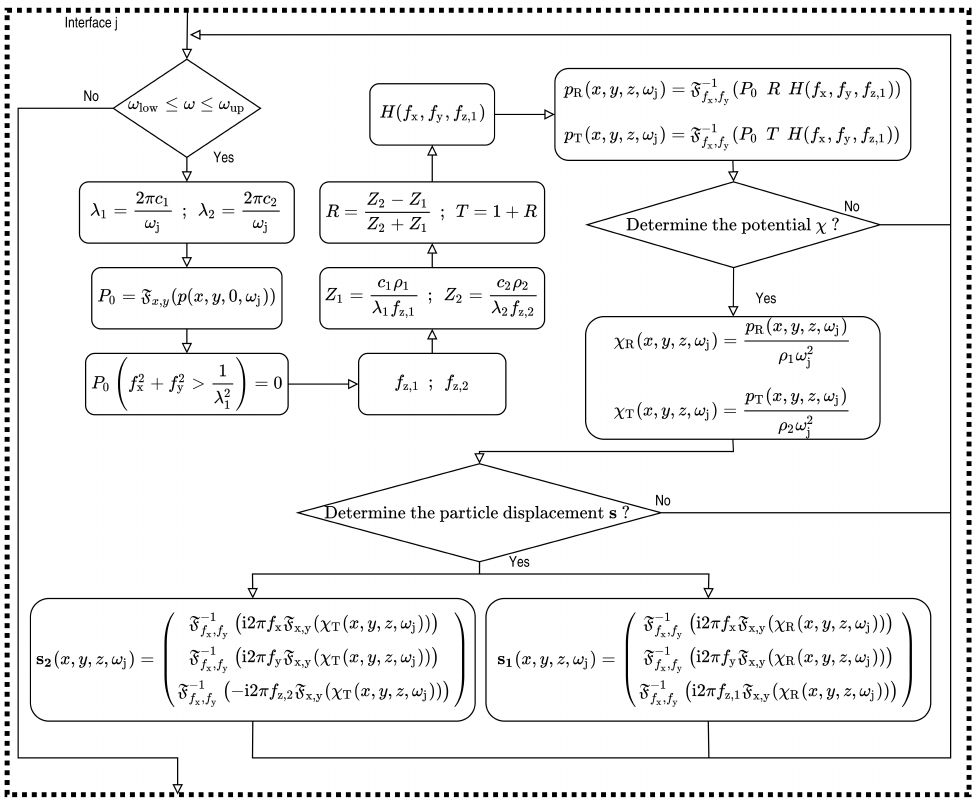
Figure 3. Flowchart of the block ”Interface j” for the practical realization of the spec-radiation method for layered fluid